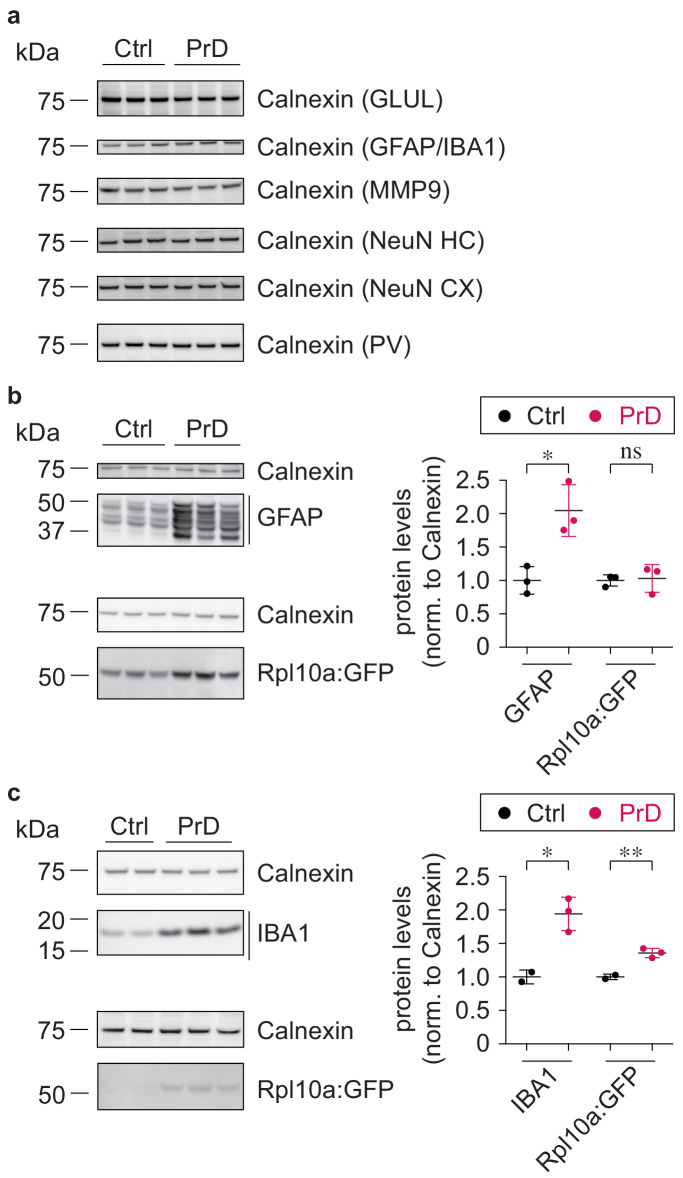
Comparison of GFP expression.(a) Western blot showing protein levels of Calnexin, used for the quantification in Figure 6. (b) Western blot and its quantification showing protein levels in control (ctrl) and terminal prion disease (PrD) GFAP Cre/Rpl10a mice (*p<0.05; ns = not significant; two-tailed t test comparing terminal PrD vs ctrl samples; error bars: standard deviation). (c) Western blot and its quantification showing protein levels in ctrl and terminal PrD Cx3cr1 Cre/Rpl10a mice (*p<0.05; **p<0.01; two-tailed t test comparing terminal PrD vs ctrl samples; error bars: standard deviation).